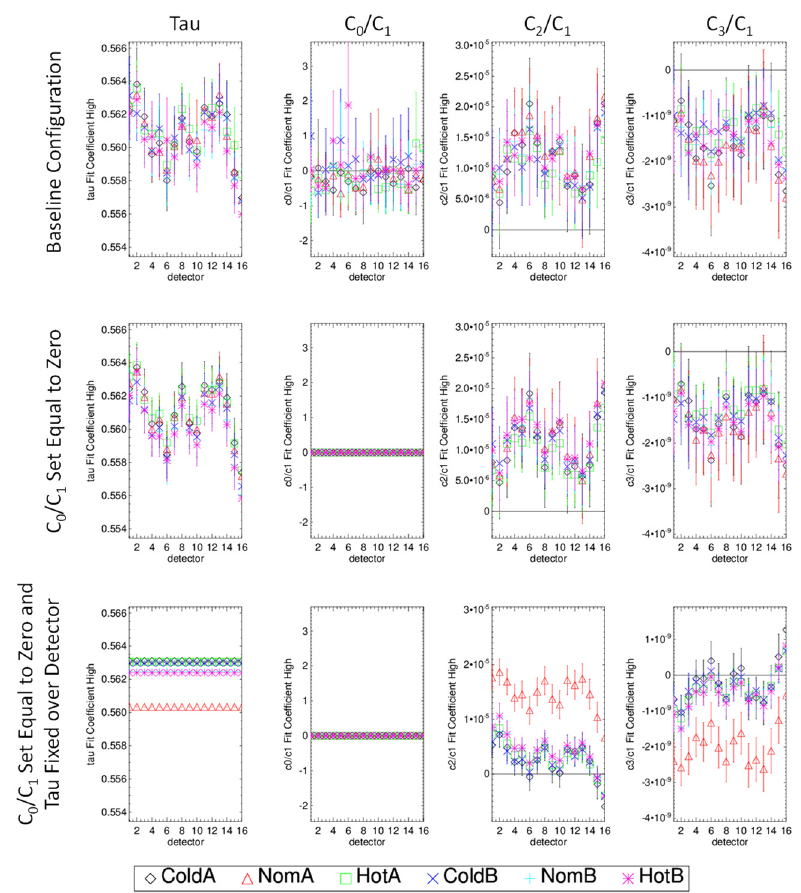
Figure 19. Band M8 fit coefficients for all detectors ( x -axis) and TVAC/electronics configurations (colors and symbols) for HAM A. The columns are tau, c 0 parameters, c 0 fixed at zero, c 0 fixed at zero, and the tau set to the detector average of each plateau. Cold, nominal, and hot plateaus and electronics sides A and B are shown here.